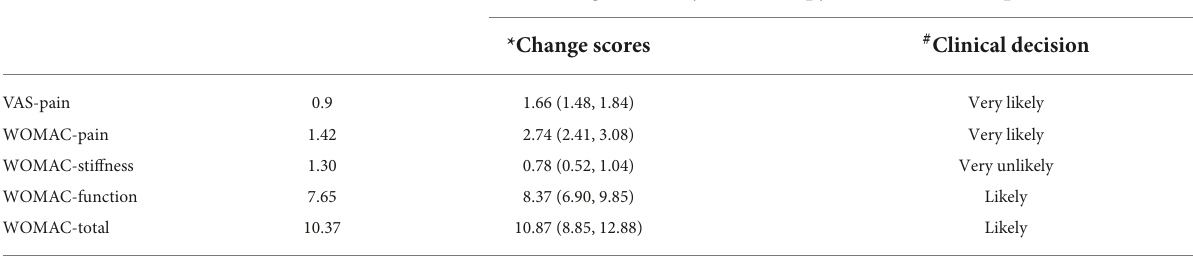
TABLE 3 Comparison of intervention effects and MCID. MCID High intensity laser therapy Vs. Placebo laser (plus